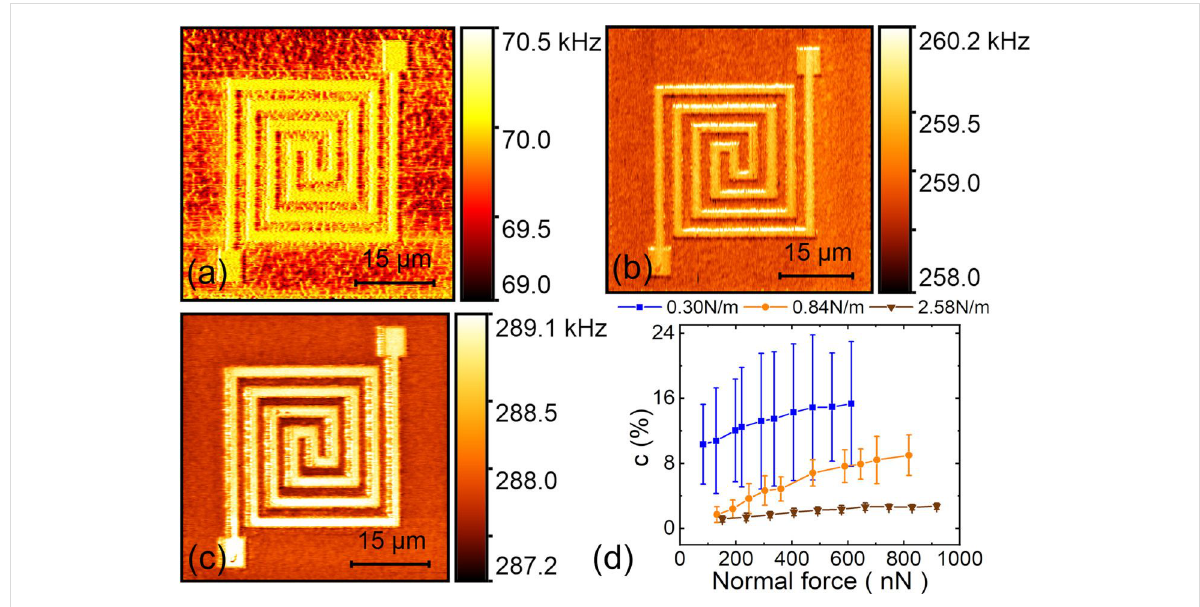
Figure 4: Influence of cantilever stiffness on CR-AFM subsurface imaging of the flexible circuit sample with a 52 nm thick top layer. (a–c) The first contact resonance frequency images of three cantilevers having stiffness of 0.30, 0.84 and 2.58 N/m, respectively. The applied normal forces were approximately 221, 189 and 237 nN. (d) Evaluated contact stiffness contrasts for the three probes under various normal forces.